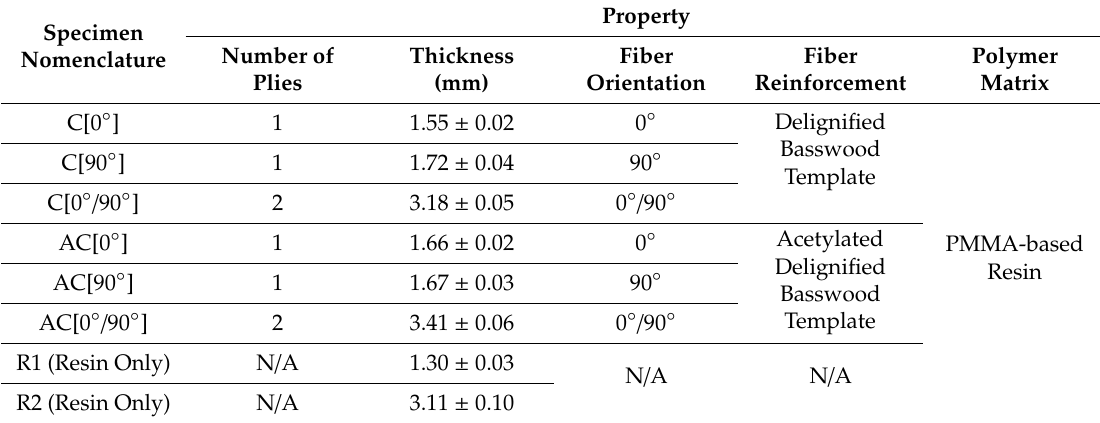
Table 1. 1- and 2-ply TWC laminate